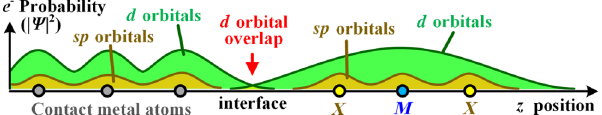
FIG. 6. Schematic showing the electron probabilities on